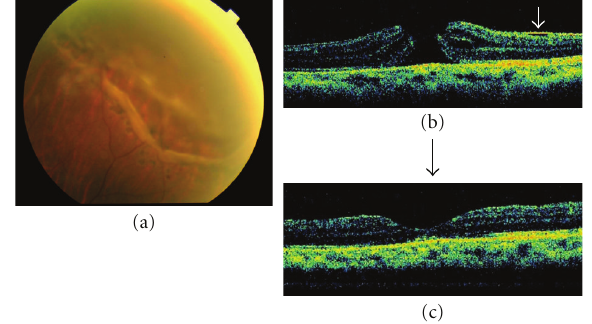
Figure 1: Fundus photographs and optical coherence tomographic (OCT) images of a representative patient (patient 4). (a) Fundus photograph shows a retinal break surrounding the scar of pho- tocoagulation with retinal detachment. (b) OCT image showing a full-thickness MH after RRD repair. A white arrow showed a secondary epiretinal membrane. (c) The MH is closed by PPV with ILM removal and gas tamponade. The final VA was 0.2.